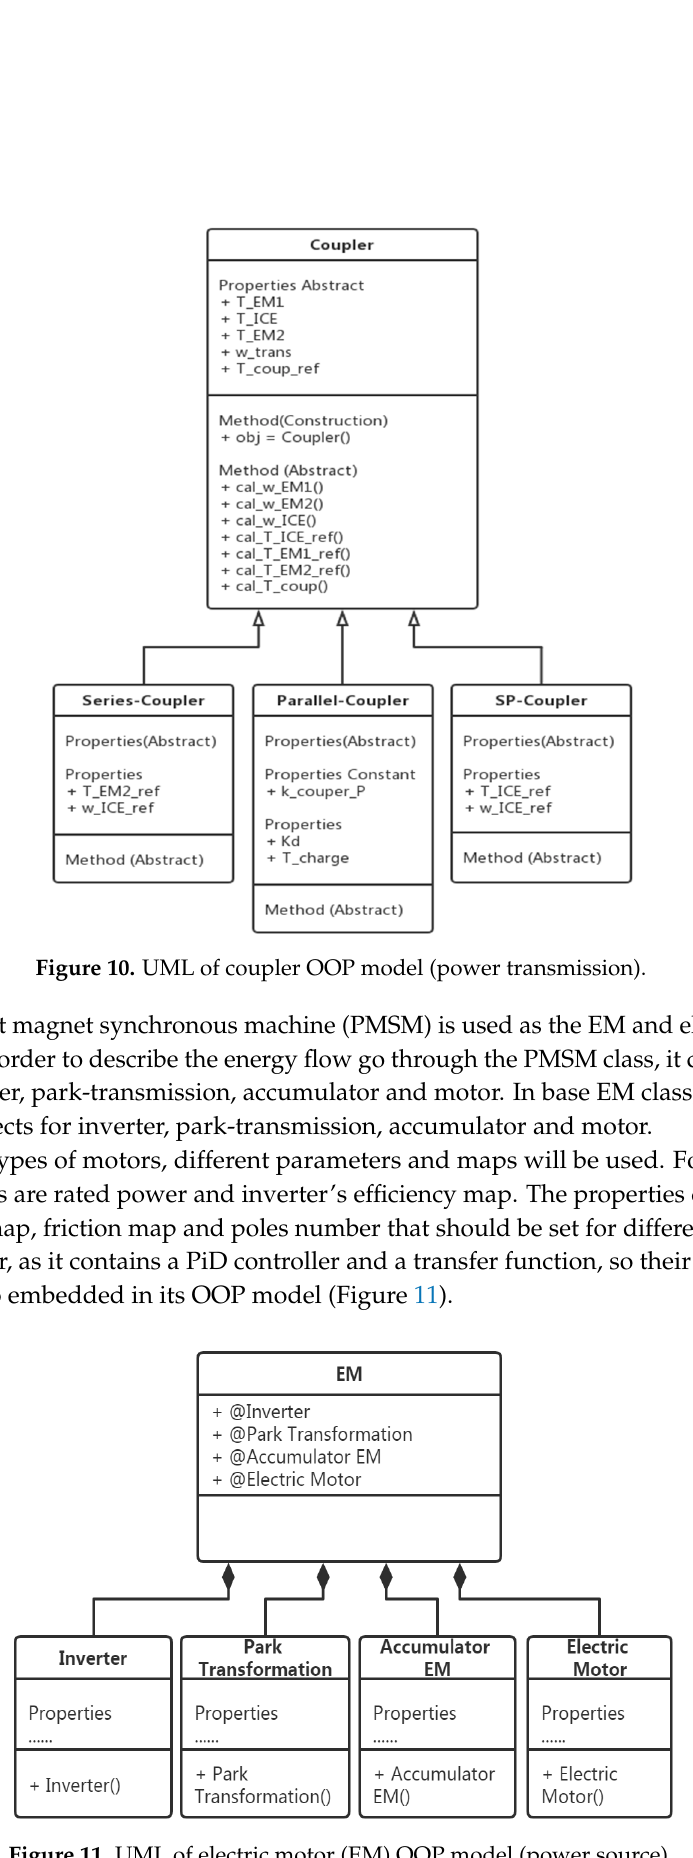
Figure 12. Main program flow chart for HEV OOP model (for series, parallel and SP). Then three driving cycle data (WLTP, Artemis-Urban and Circuit-Magny-cours) will be loaded into the main-program which is the reference speed values. After that, the vehicle object class calculates the torque needed by transmission by using these speed values. Next, different control-signals will transfer from CsT-class to local-controller of coupler-class in order to obtain the ideal input signals for power-sources. These ideal input signals will enter to power sources’ objects to calculate the actual output values.